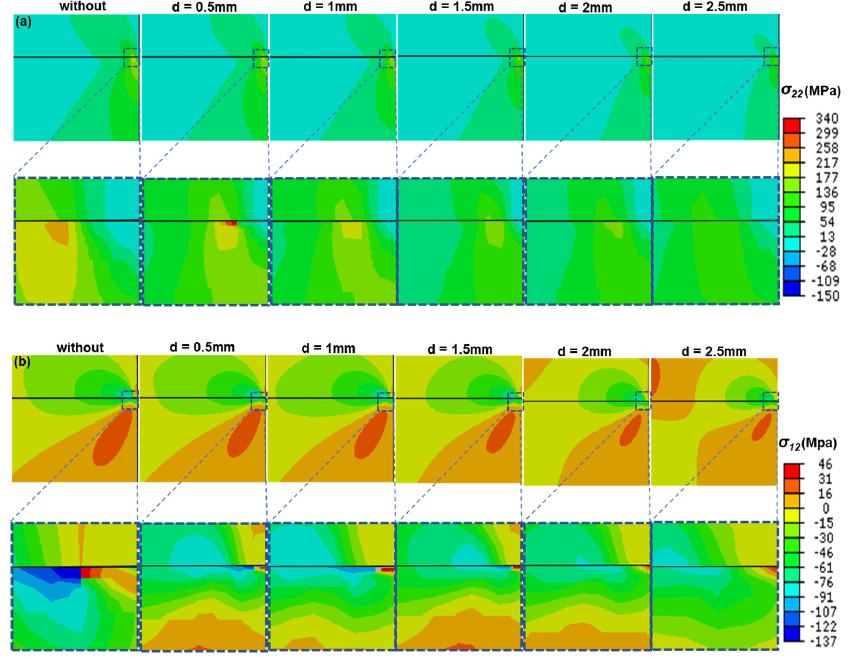
Figure 4. Variation of stress field: ( a ) σ 22 and ( b ) σ 12 at crack tip for different depths of 3 mm thickness of TC with one vertical crack.